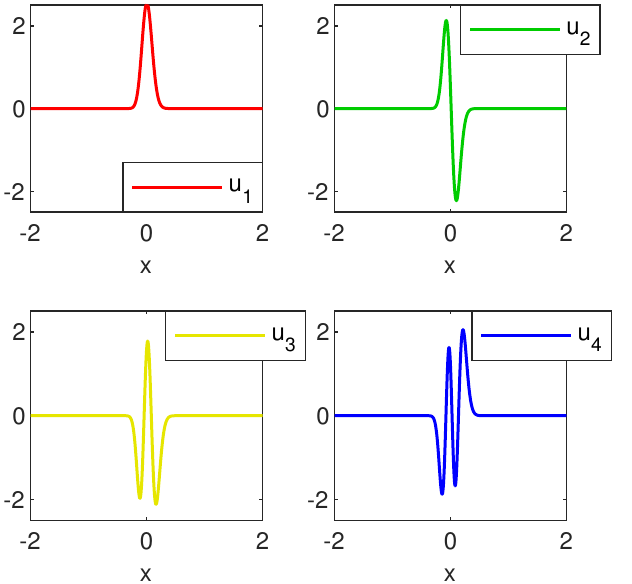
Figure 5. Zoom in the first four eigenvectors of problem (1) equipped with the Morse potential